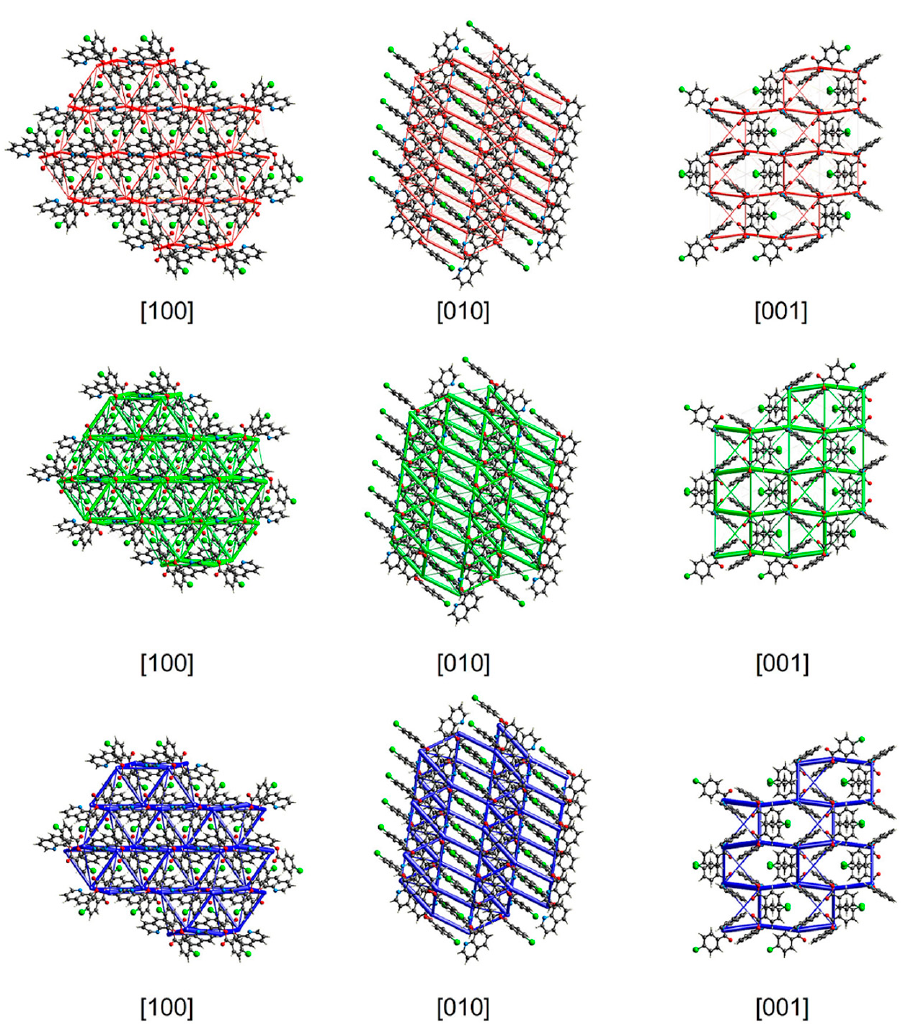
Figure 7. Energy framework diagrams for 3 , described as electrostatic (red) and dispersion (green) contributions to the total interaction energies (blue), showing the energetic topology in the packing along [100], [010], and [001] directions. The frameworks are generated within a radius of 10 Å.